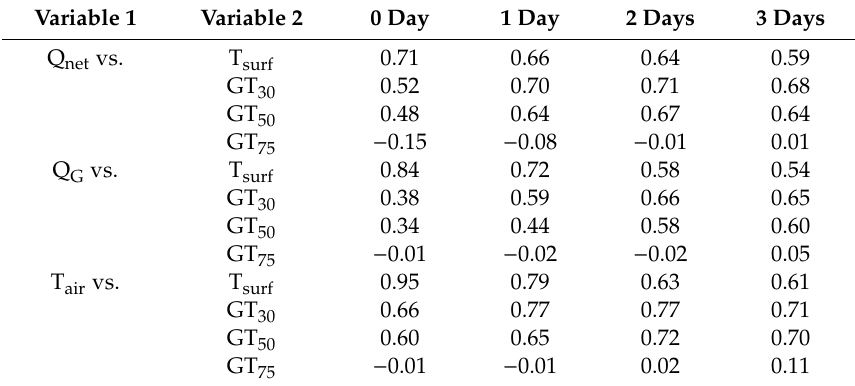
Table 3. Daily average correlation coe ffi cients between ground surface temperatures (T surf ),